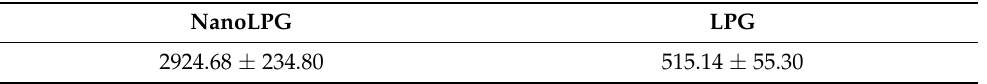
Table 2. Antioxidant activity by oxygen radical absorbance capacity (ORAC). Results in µ mol TE (Trolox